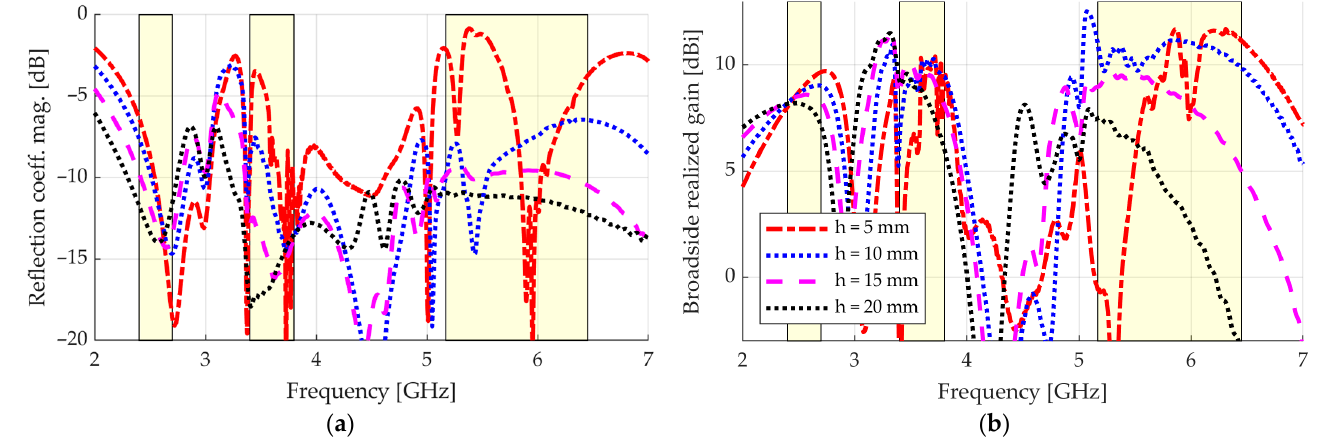
Figure 11. Simulated results when the spacing ℎ is varied.: ( a ) reflection coefficient magnitude; ( b ) broadside realized gain.